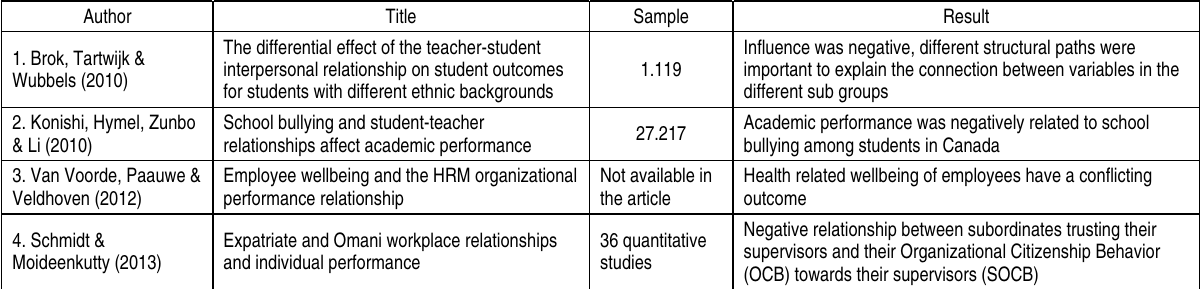
Table 3. International studies into interpersonal